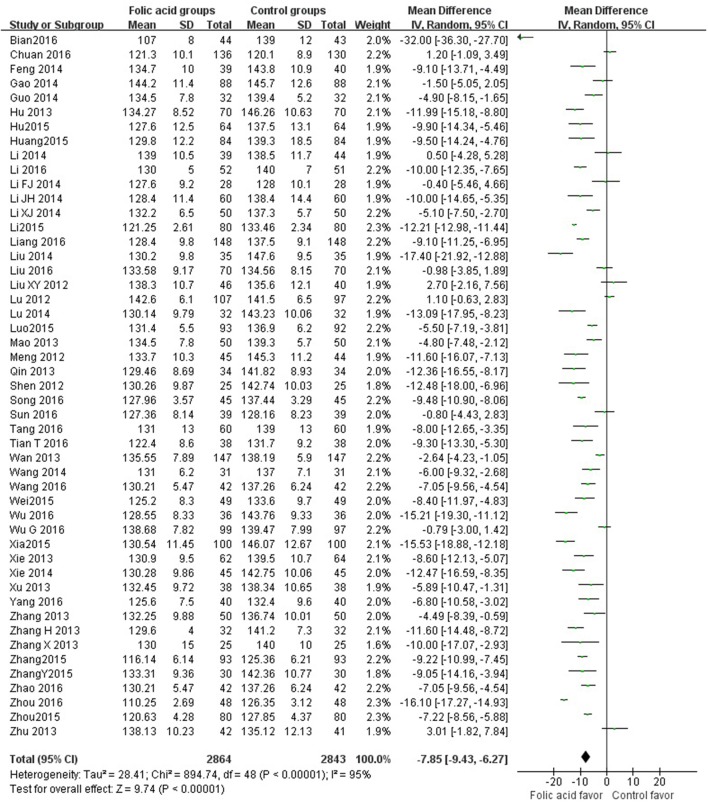
Forest Plot of effect sizes for SBP; SBP: Systolic Blood Pressure.